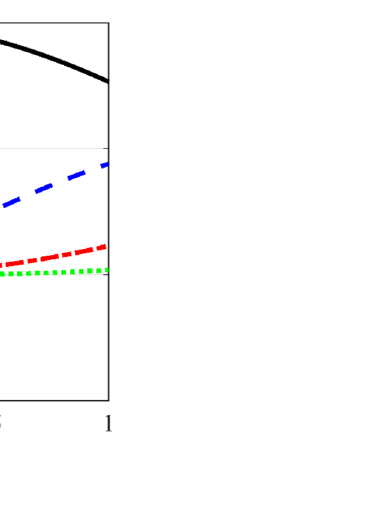
Figure 1. The Bessel functions of the first